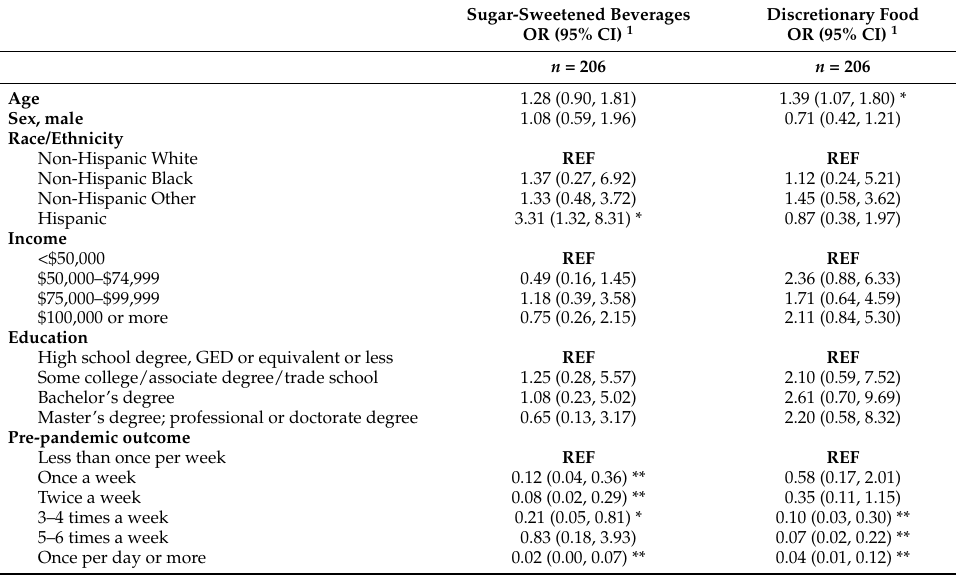
Table 3. Associations between sociodemographic characteristics and changes in dietary intake among children ages 4–12 years in 4 cohorts participating in the Environmental influences on Child Health Outcomes Program.